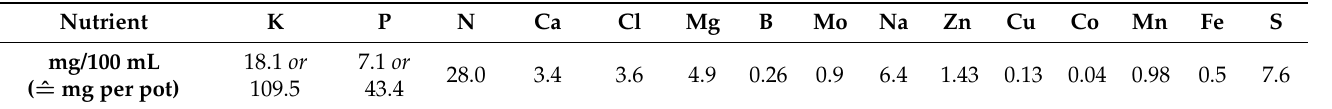
Table 2. Composition of the fertilizer solution added per pot over the complete growing season. Two different fertilizers were prepared, one containing a small concentration of K 2 HPO 4 , the other one containing a high concentration of K 2 HPO 4 .